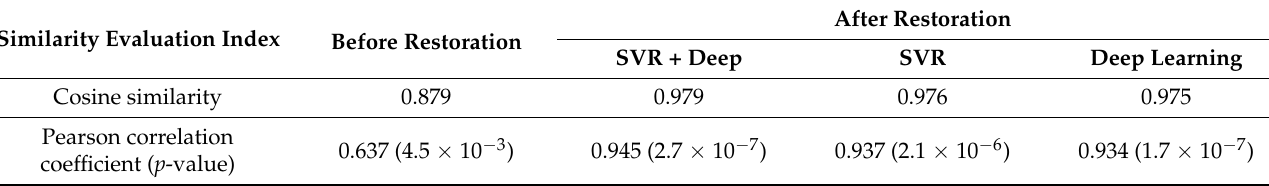
Table 3. Test results in terms of similarity before and after rPPG restoration by using two metrics such as cosine similarity and Pearson correlation coefficient with the p